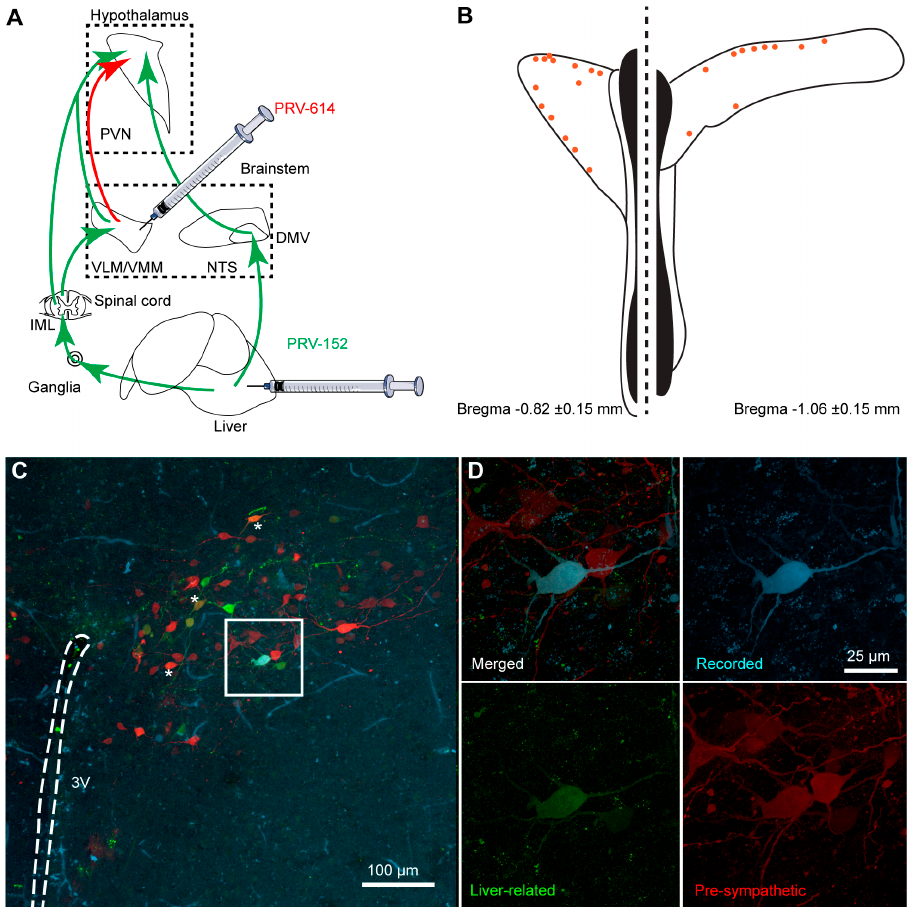
Figure 4. Identification of liver-related neurons in the PVN with projections to the ventral brainstem. ( A ): Schematic illustration of the viral inoculations. The liver was inoculated with PRV-152 (green) to identify liver-related neurons, then PRV-614 (red) was injected into the VLM to identify PVN neurons with projections to the ventral brainstem. Double-labeled neurons represent VLM-projecting liver-related PVN neurons. ( B ): Location of recorded pre-sympathetic, VLM-projecting liver-related PVN neurons. Orange dots represent the approximate location of the recorded neurons. The dotted line represents the 3 rd ventricle. Note the different distance from Bregma (left and right), representing two distinct parts of the PVN. ( C ): A confocal image (20 × ) of the PVN illustrates liver-related neurons (green), VLM-projecting neurons (red), and liver-related neurons with projections to the VLM (yellow/orange). The stars indicate some of the ventral brainstem projecting liver-related neurons. Dotted line indicates the 3 rd ventricle. Boxed area is enlarged on ( D ). ( D ): Enlarged image of the boxed area on C illustrates a recorded neuron (blue, 60 × ), which is a liver-related VLM- projecting neuron in the PVN. 3V: third ventricle; DMV: dorsal motor nucleus of the vagus; IML: intermediolateral nucleus of the spinal cord; NTS: nucleus tractus solitarius; PRV: pseudorabies virus; PVN: paraventricular nucleus of the hypothalamus; VLM: ventrolateral